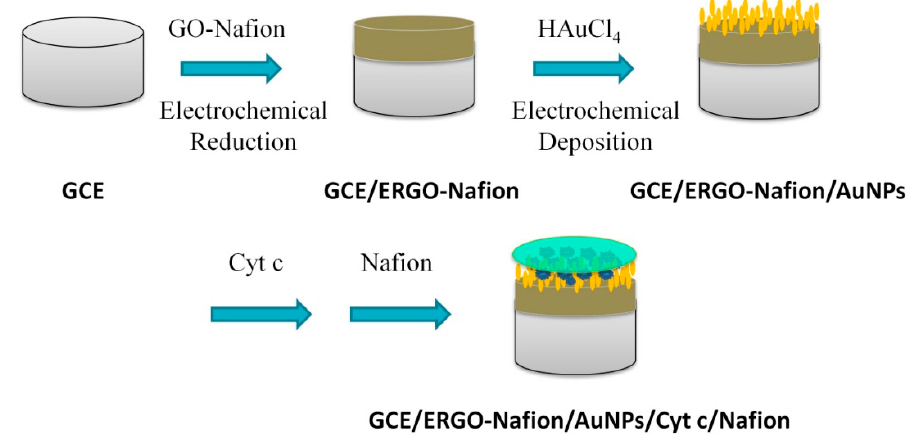
Figure 1. Step-by-step construction of a GCE/ERGO-Nafion/AuNPs/Cyt c/Nafion electrode.